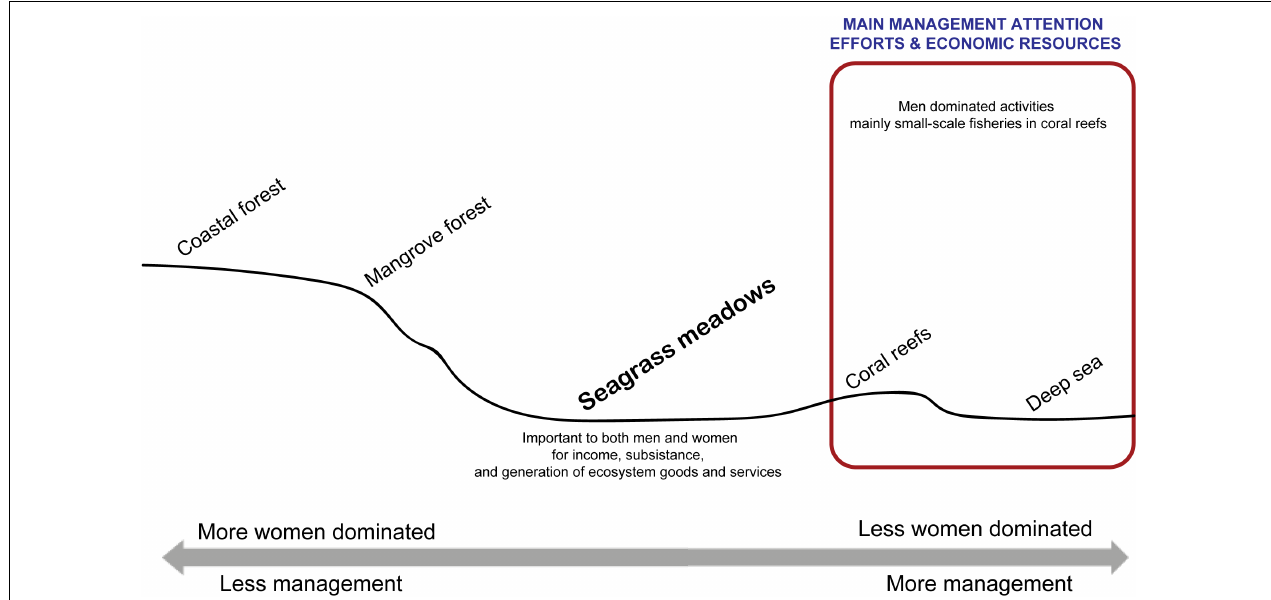
FIGURE 1 | The tropical seascape with differential gender domination and SSF management efforts in Zanzibar, Tanzania. Data from de la Torre-Castro et al. (2017).